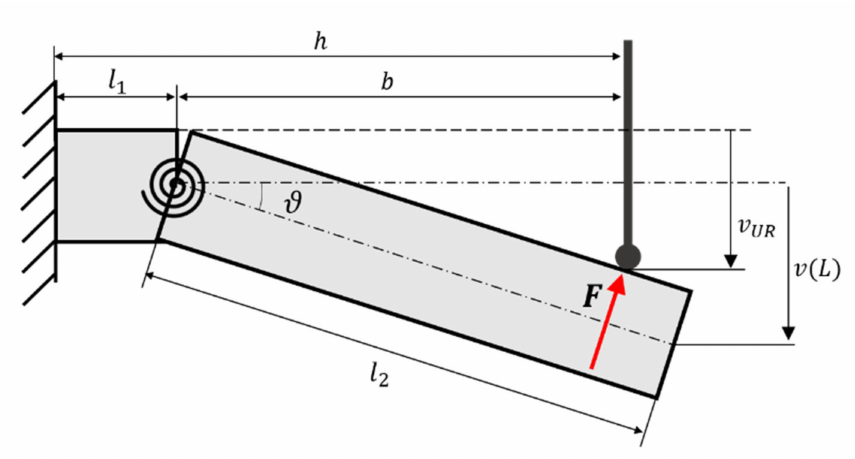
Figure 8. Static test for stiffness estimation, experimental